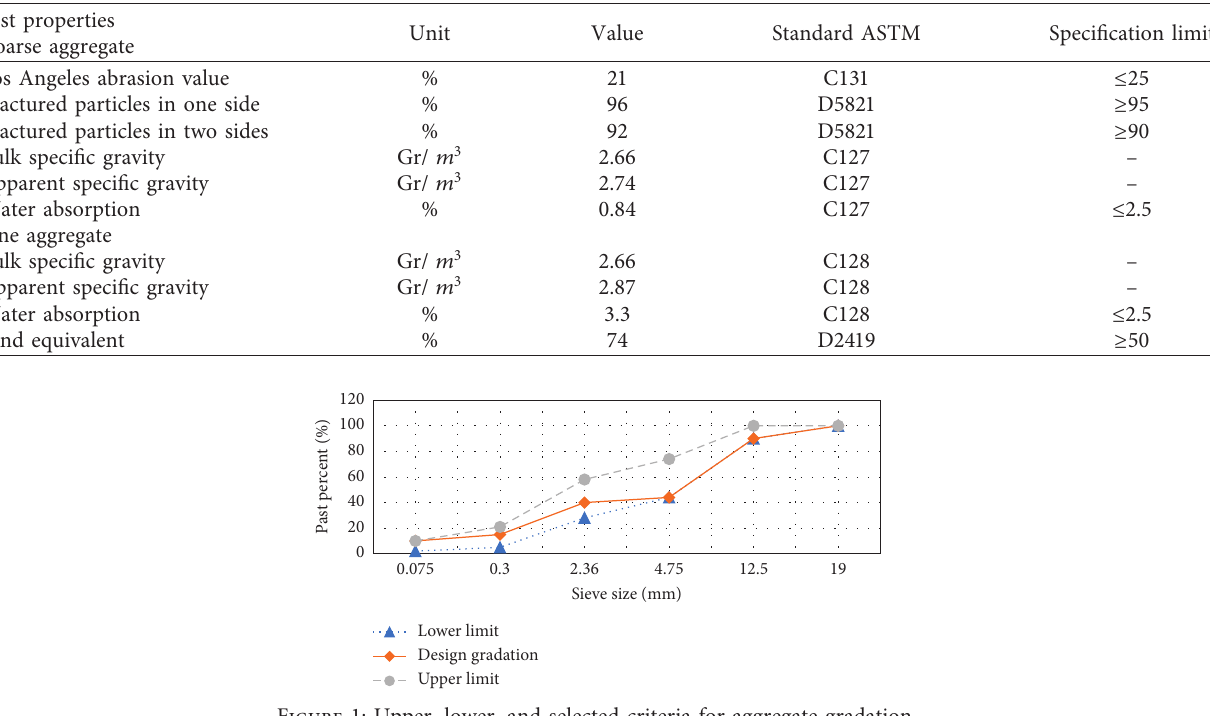
Table 2: Physical characteristics of the coarse and fine aggregates.